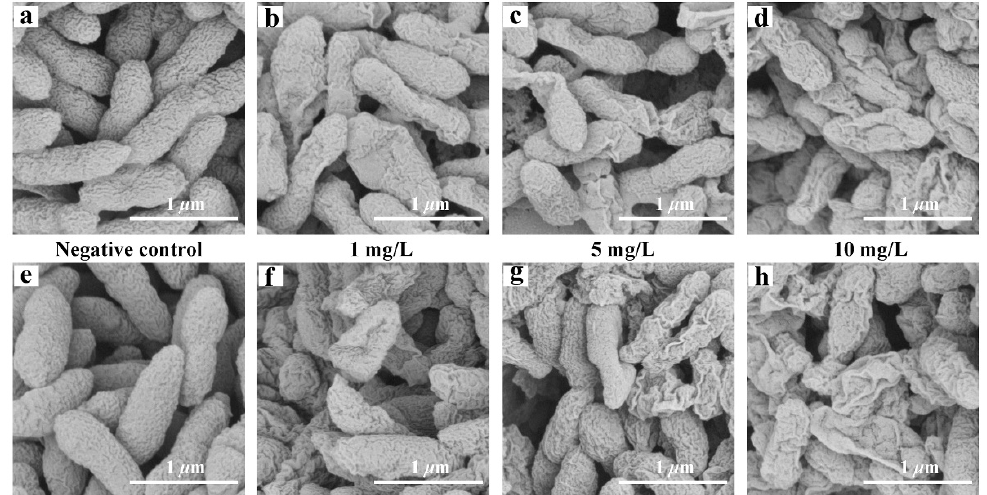
Figure 7. Changes in bacterial morphology of Xoo ( a – d ) and Xoc ( e – h ) at 10, 5, and 1 mg/L.